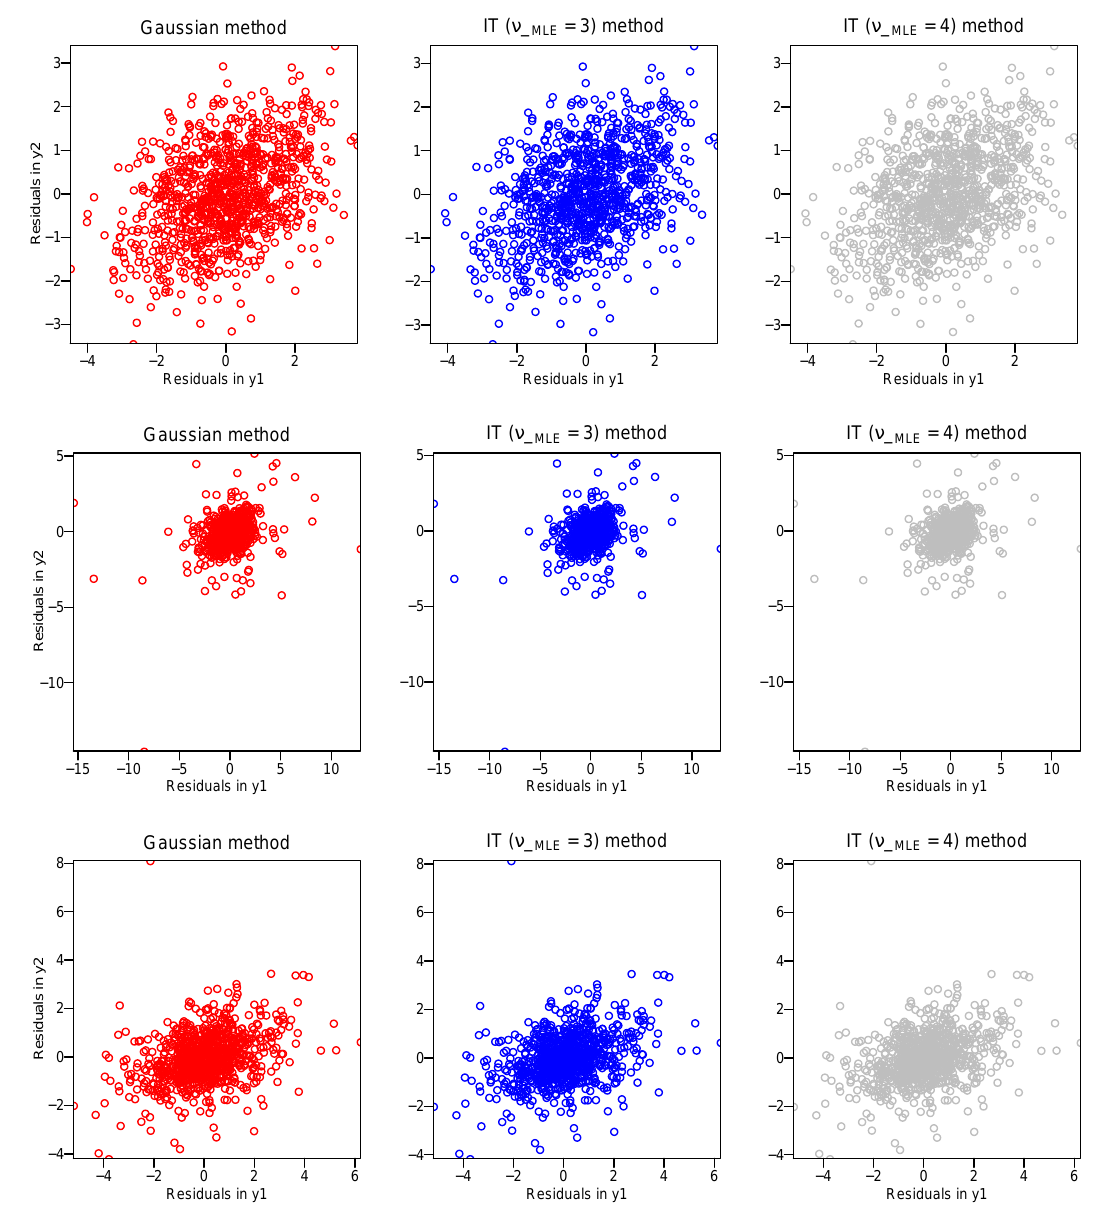
Figure 3. Toy data: scatterplots of residuals in the Gaussian DGP (respectively, the IT DGP with ν DGP = 3, the IT DGP with ν DGP = 4) on the first row (respectively, the second row, the third